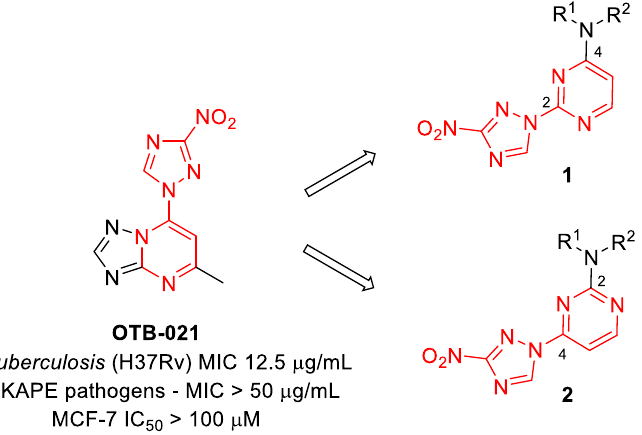
Figure 2. Structure of OTB-021 hit compound and the two isomeric series of simplified analogs ( 1 and 2 ) investigated in this work.